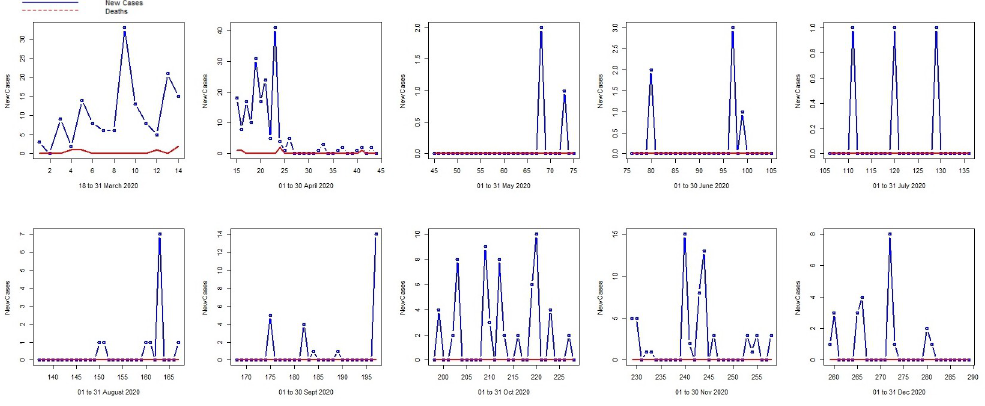
Fig 1. The COVID-19 cases versus death series in